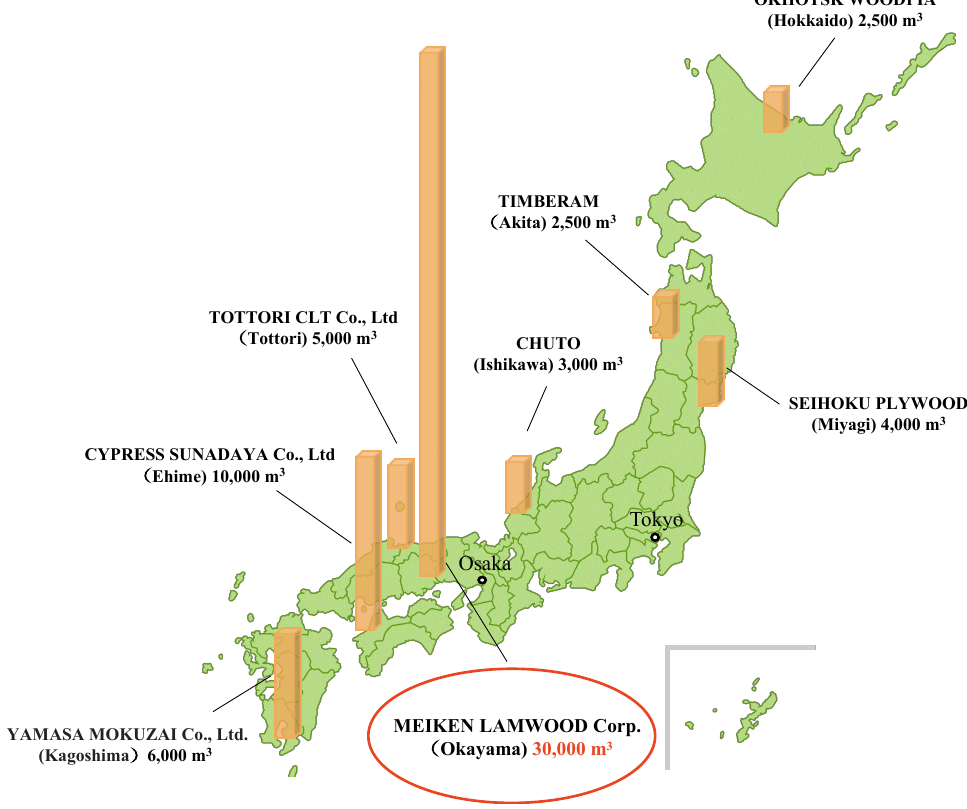
Figure 1. CLT manufacturers certified by Japanese Agricultural Standards [13] (the name of the prefecture is in brackets; values represent the production